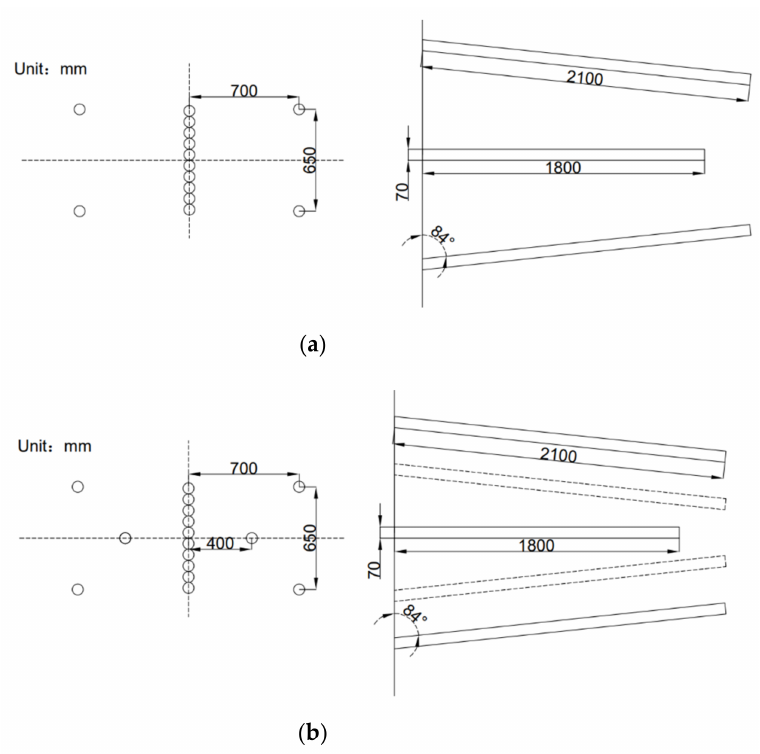
Figure 6. Plane and section arrangement of cutting mode. ( a ) Test 1; ( b ) Test 2.